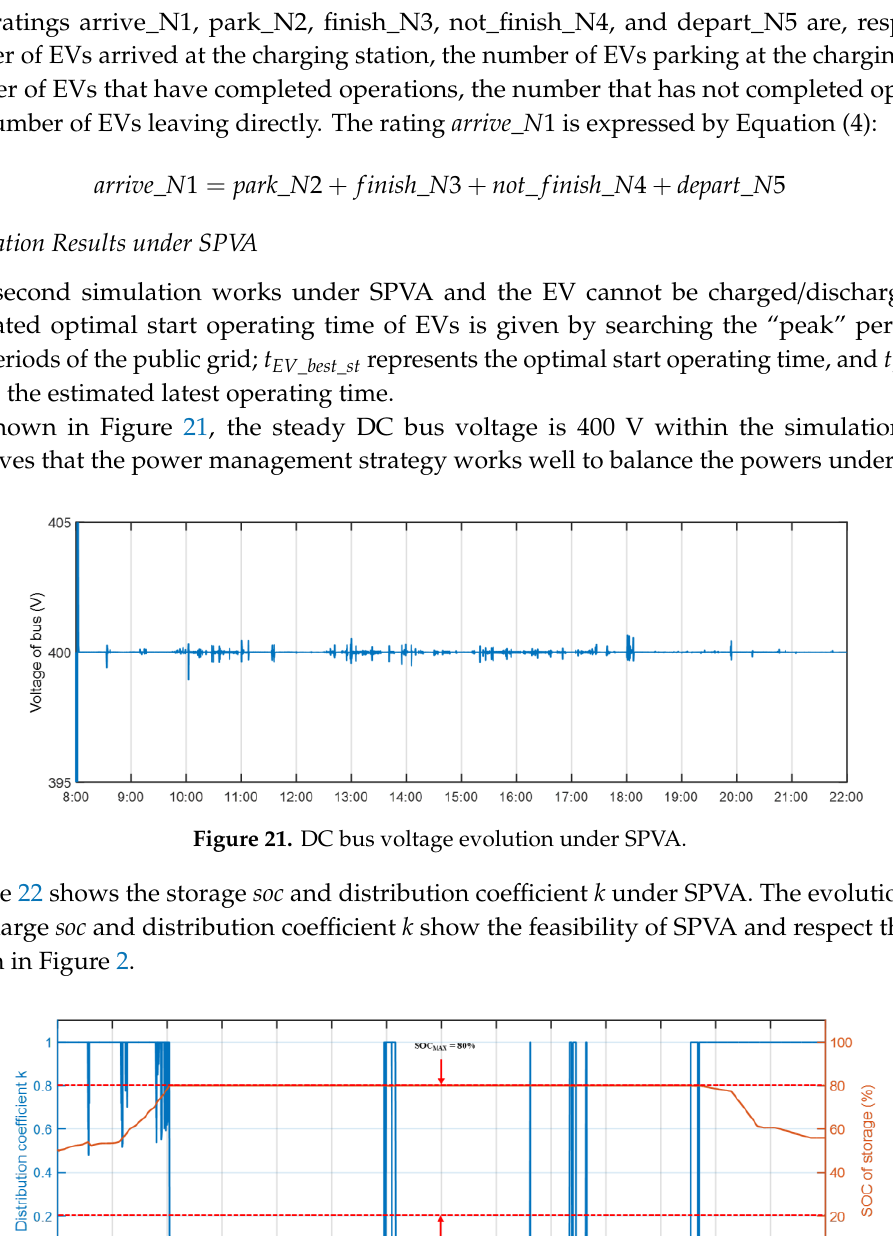
Figure 22. Storage 𝑠𝑜𝑐 and distribution coefficient 𝑘 under SPVA.